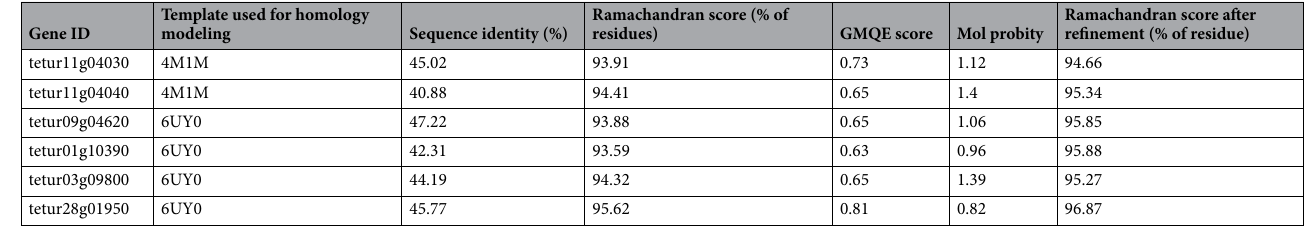
Table 2. Details of scores obtained for target ABC transporters by Swiss-model and 3D-refine servers.